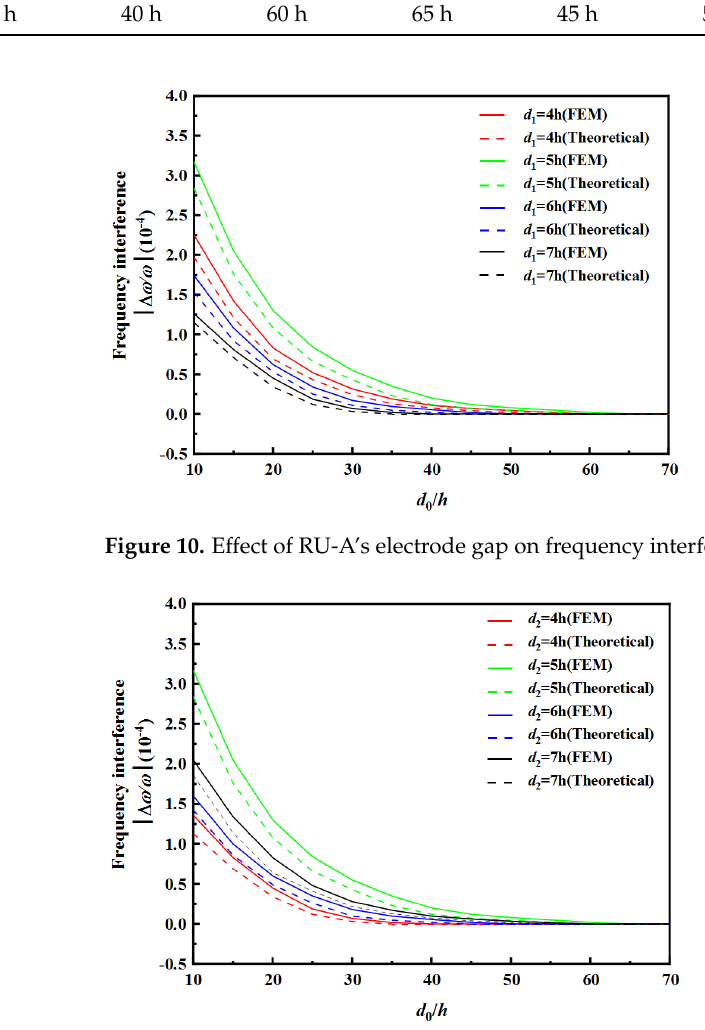
Figure 11. Effect of RU-B’s electrode gap on frequency interference.